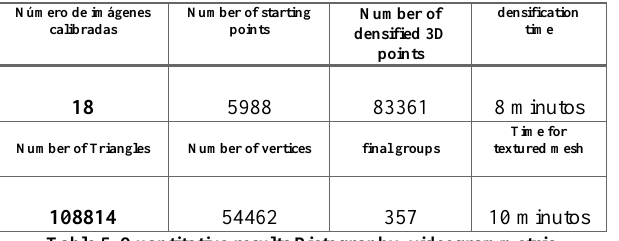
Table 5. Quantitative results Pictography, videogrammetric